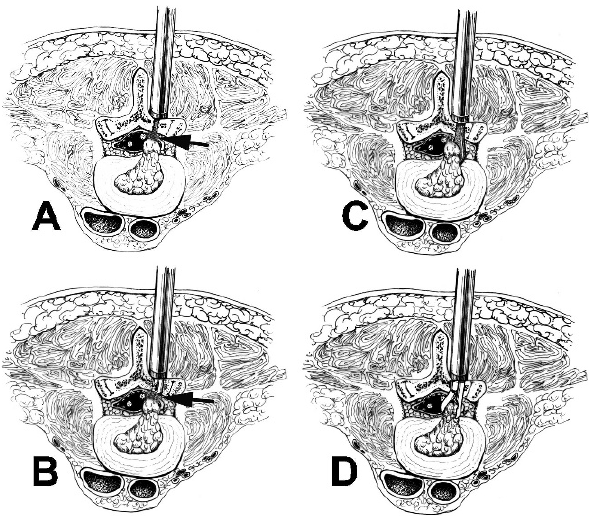
Figure 2 - The technical note for repeated microendoscopic discectomy for recurrent lumbar disc herniation is displayed using a schematic diagram. A: The paraspinal muscles are first moved in the original incision and the secondary expansion tube is inserted and propped against the vertebral plate. Then, the operating channel is progressively expanded and installed, the scar tissue and residual muscle tissue between the vertebral plates are cleaned and the bone border of the last fenestration operation is revealed. B: The adhesion between the bone border and scar tissue is dissected (see arrows) with a nerve dissector or Kerrison based on anatomy and imaging features and the scar tissue is further carefully removed or resected. The window is then expanded to the desired range with a Kerrison. C: The anatomical relationship between the dural sac and nerve root is then carefully identified, the adhesion is then dissected and the nerve root and dural sac are inwardly retracted on the surface of the disc herniation with a 90-degree short spherical probe or dissector. Then, the herniation can be clearly exposed. D: The intervertebral disc herniation is incised and the broken disc tissue is